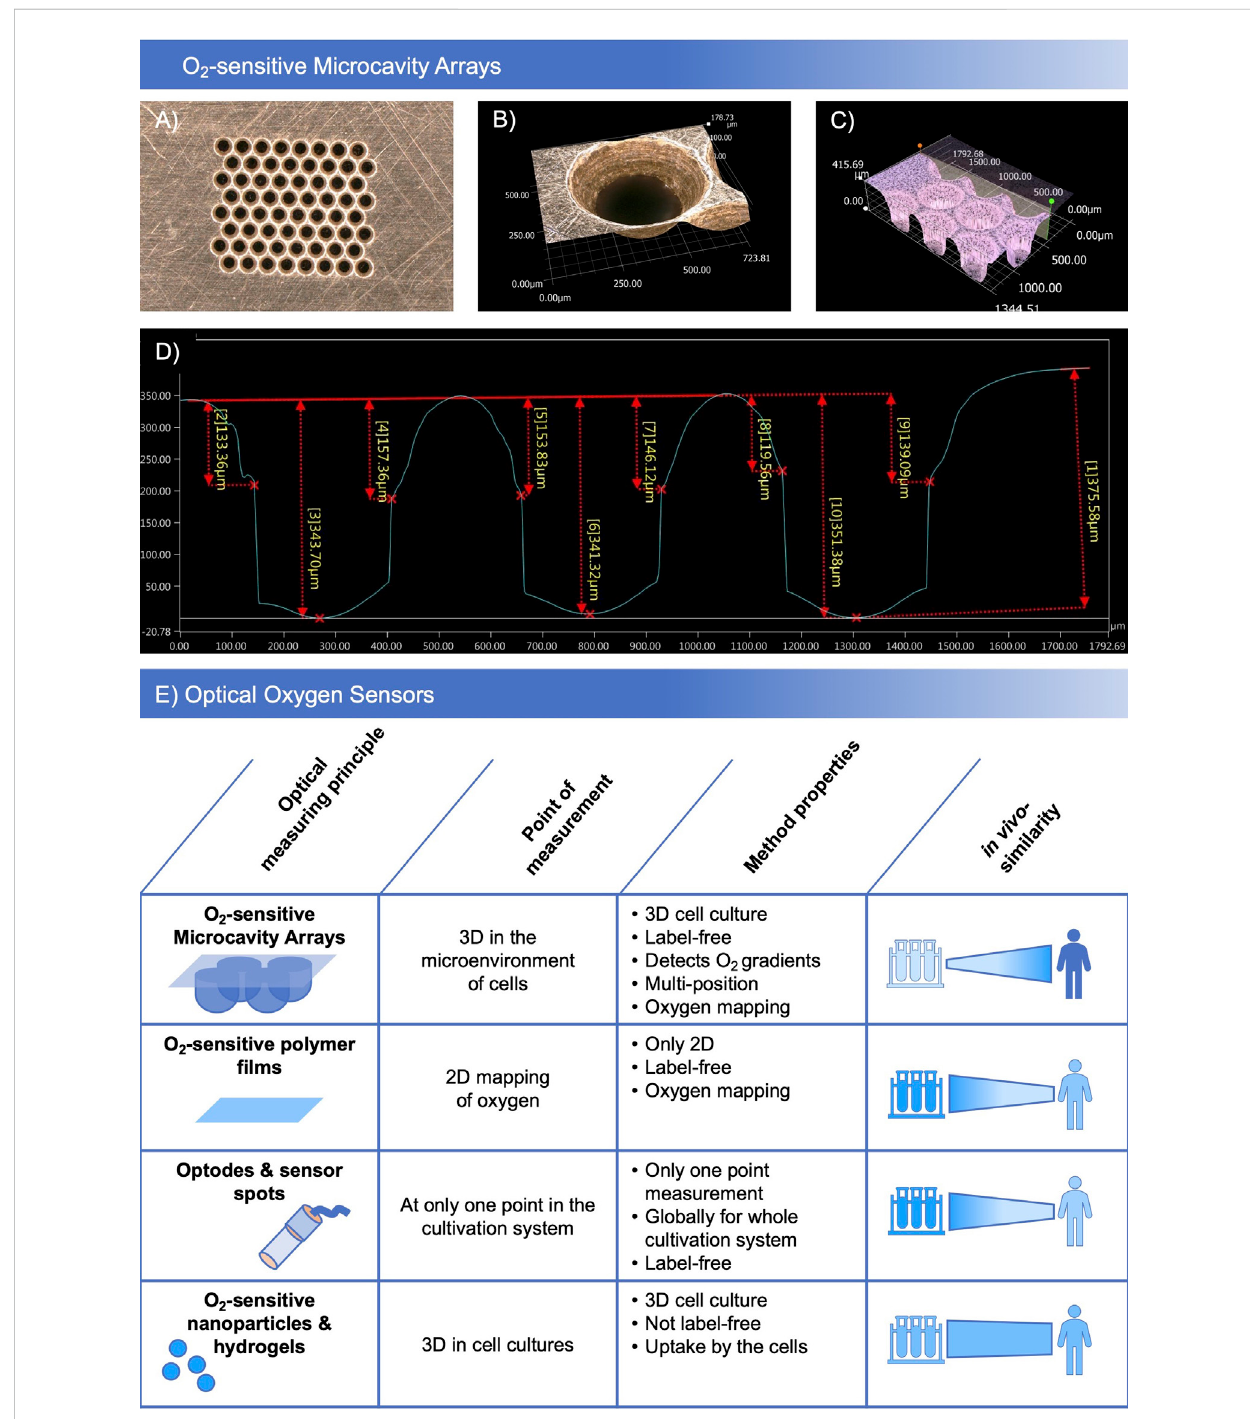
FIGURE 1 Manufacturingsensorarrays: (A) Brassmoldingmaskwith8×8microcavitiesandabevelattheuppersideofthemask. (B) Detailedviewofthebevel. (C) Microscopicimageofthedepthpro fi leofthemicrocavities. (D) Characterizationoftheformingdepth.MicroscopicimagestakenwithaKeyenceVHX 5000 digital microscope, magni fi cation ×20 (A) and ×200 (B,C) . (E) Comparison of O 2 -sensitive microcavity arrays with other established optical oxygen